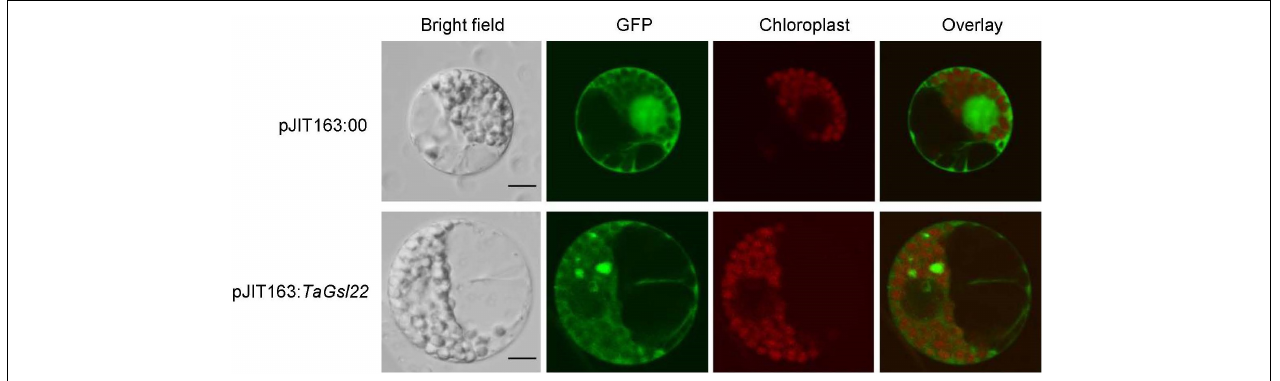
FIGURE 3 | Subcellular localization of the TaGSL22 protein. pJIT163:00, pJIT163 empty plasmid; pJIT163: TaGSL22 , pJIT163 recombinant plasmid with TaGSL22 ; overlay, superposition of green fluorescent protein (GFP) channel and chloroplast channel; bright field images show the equivalent field observed under white light. Scale bars: 10 µ m.